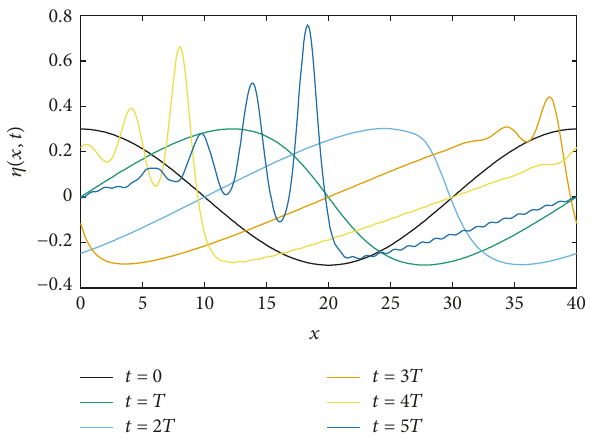
Figure 16: Emergence of soliton trains according to KdV2 from initial cosine wave. 𝐴 = 0.3, 𝑇 = 50